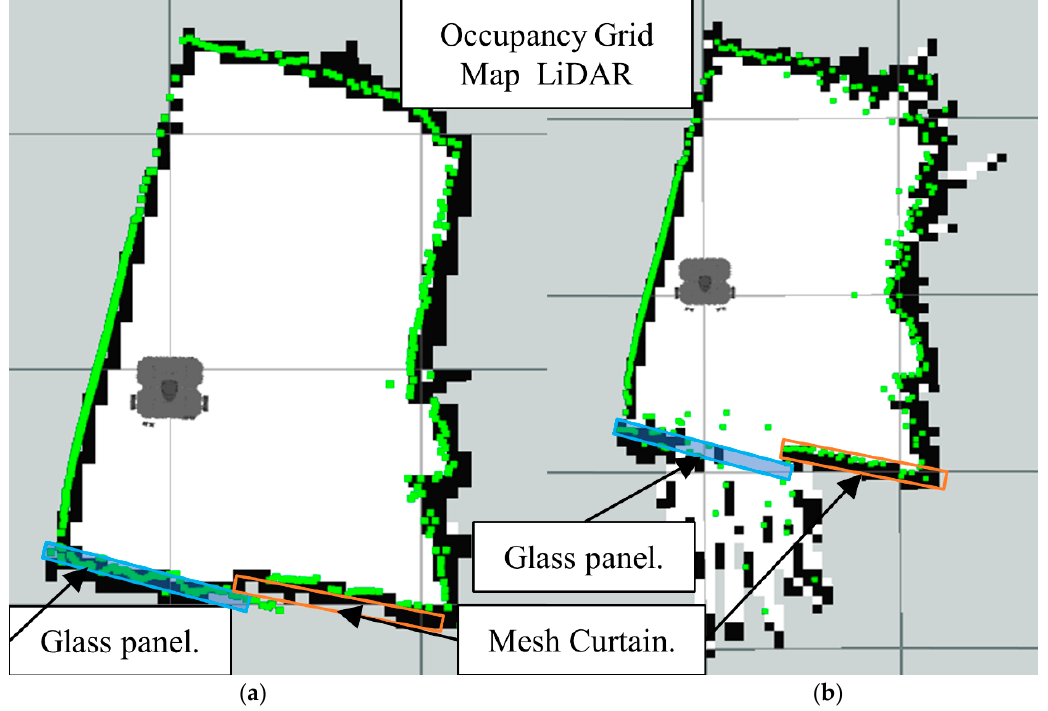
Figure 26. Occupancy grid maps showing the: ( a ) Ground truth (reference map); ( b ) LiDAR gener- ated map.